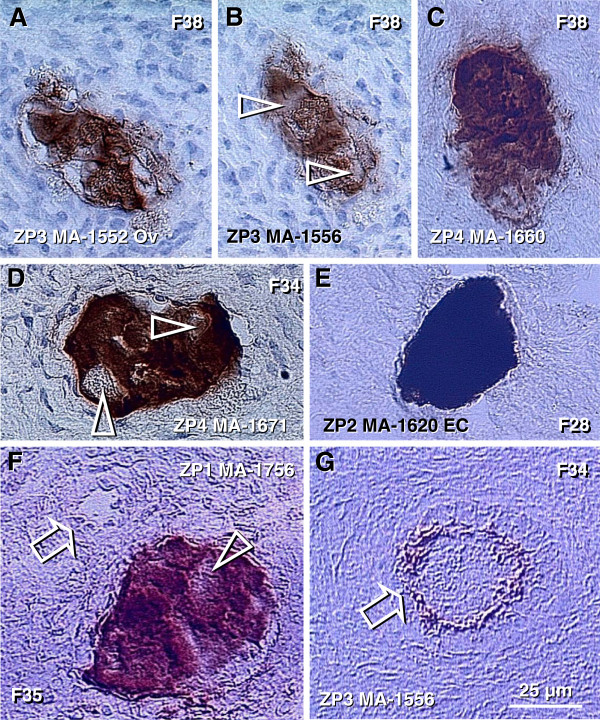
Intravascular degenerating human oocytes. Degenerating oocytes in venules of ovarian medulla (A D and F) and uterine endocervical stroma (E) expressing zona pellucida proteins identified by MAb clones against ZP3, ZP4 and ZP 2
[198] as indicated in panels. MAb to ZP1 was kindly provided by Dr. Satish K Gupta. Arrowheads indicate unstained oocyte nuclei, arrow in F shows an arteriole, arrow in G shows ZP expression at the oocyte surface in a normal secondary follicle. F28-F38 indicate patients’ ages. Panels A and C adapted from
[139] with permission, © Elsevier.